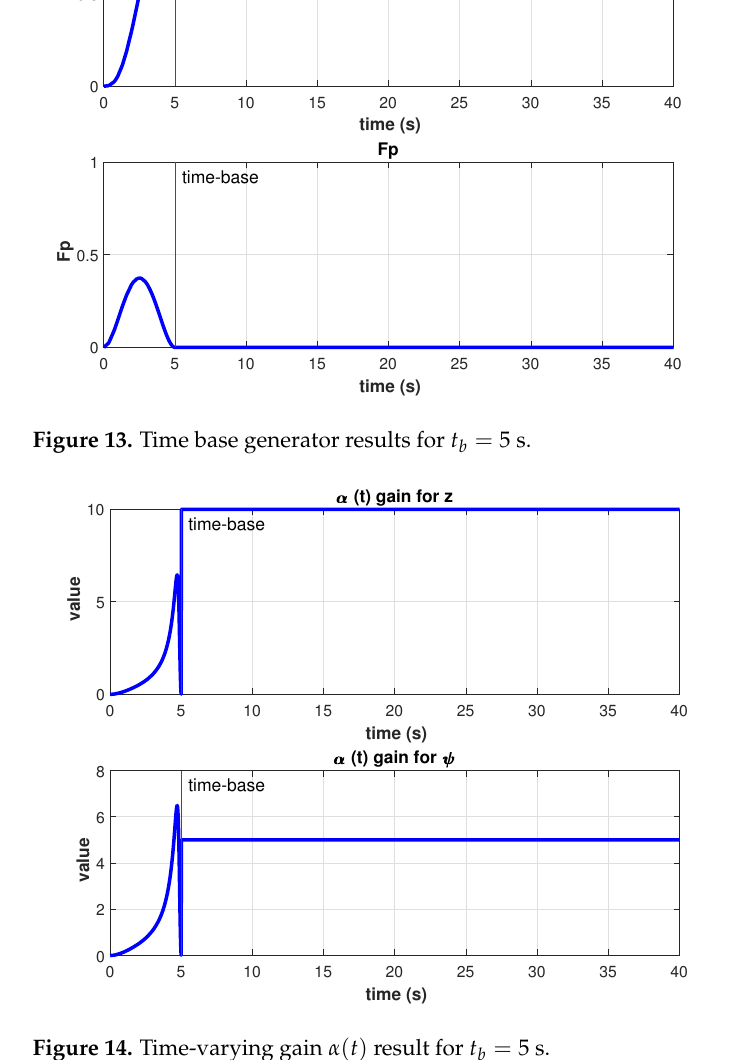
Figure 14. Time-varying gain α ( t ) result for t b = 5 s.